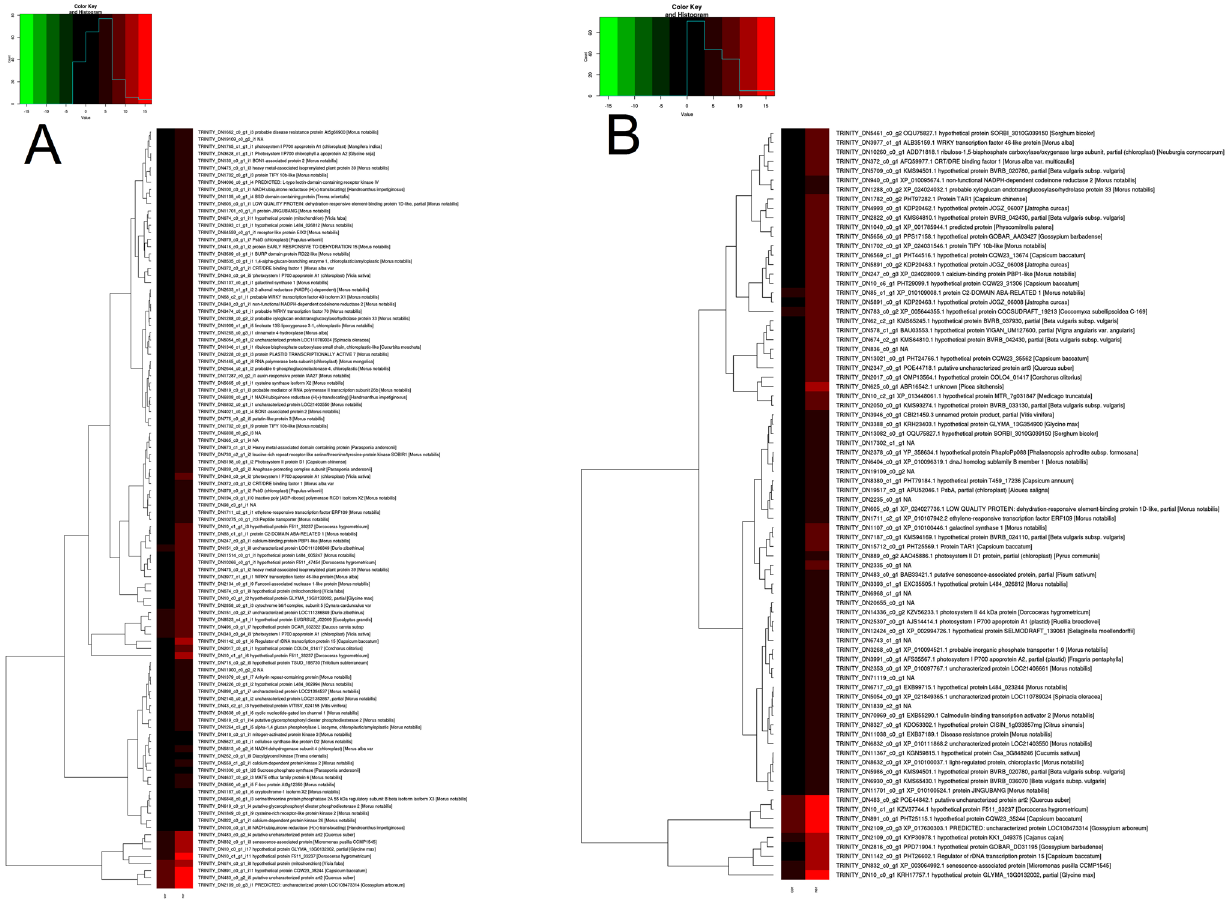
Figure 10. Hierarchical clustering of differentially expressed top 5% up-regulated ( A ) isoforms and ( B ) unigenes in relation to NS7 vs. CO7. The higher score with different colour represents the higher level of